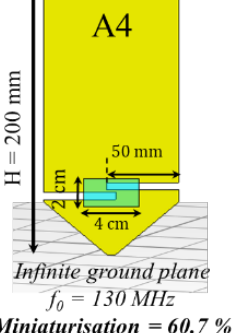
Figure 10. ( a ) Miniaturized monopole antenna A4 by the P-MDM of dimensions 4 × 2 cm with two slots of length 51.3 mm. ( b ) Miniaturized monopole antenna A5 by the P-MDM with two slots of dimensions 93 × 10 mm .